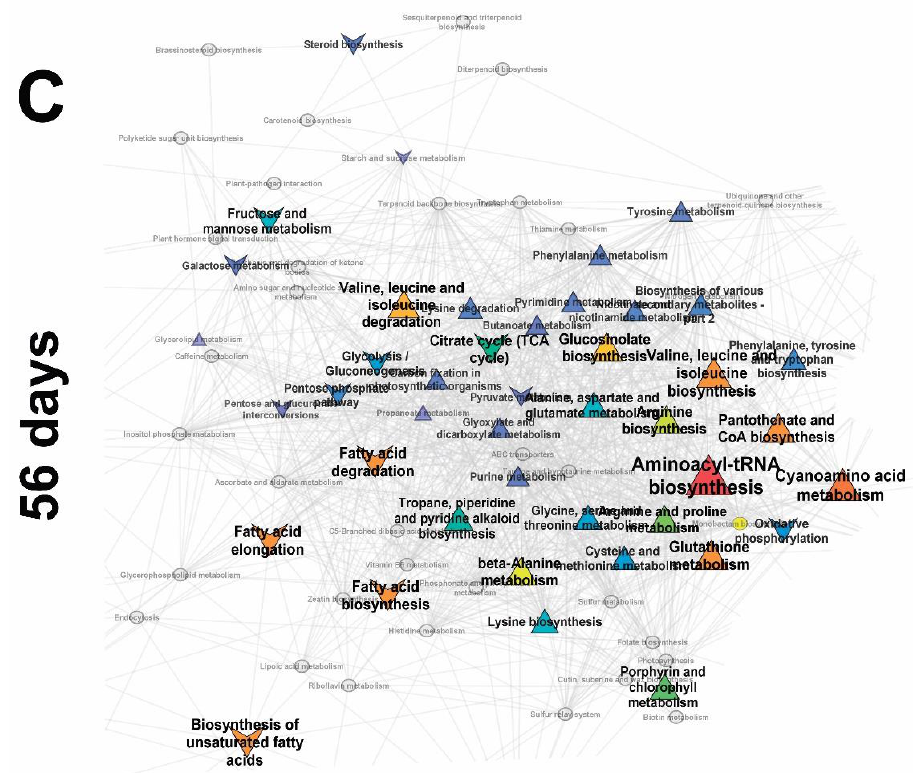
Figure 5. Enrichment analysis. Graph of the KEGG pathways. Nodes are pathways, if paths have common metabolites, then they are connected by edge, attracting nodes with strength proportional to number common metabolites. Color denotes significance of influence of mycorrhization on the path (FDR), derived from MSEA predictive component loadings of OPLS-DA models for comparison of the metabolome of the mycorrhized and control pea cv. Finale roots sampled at 21 ( A ), 42 ( B ) and 56 day ( C ). Size denotes strength of influence (|NES|), upward direction denotes activation with mycorrhiza, downward denotes repression.